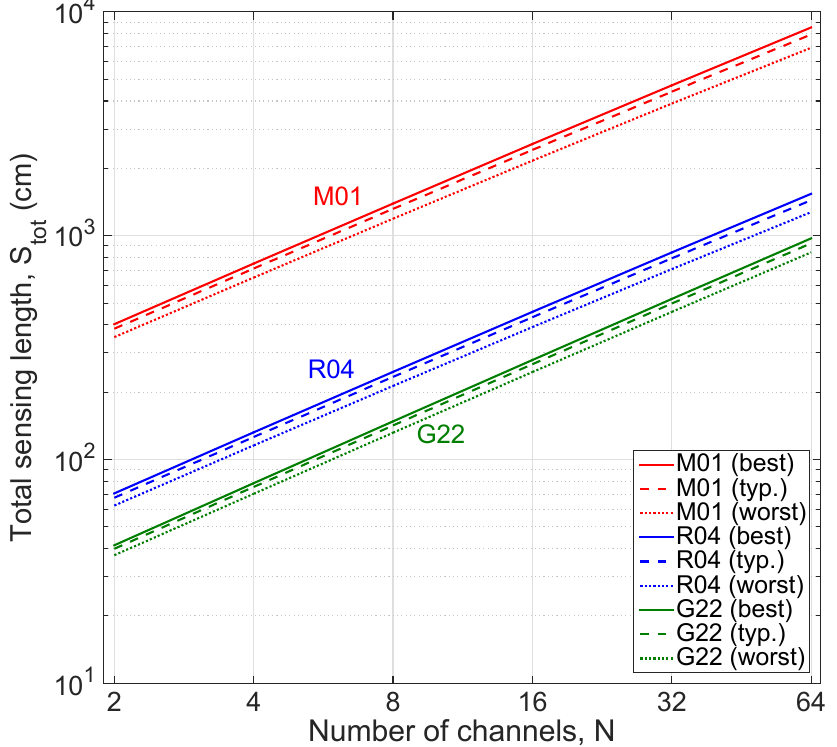
Figure 8. Total sensing length S tot for each fiber (fiber 6, M01; fiber 3, R04; fiber 7, G22), as a function of the number of SLMux channels.